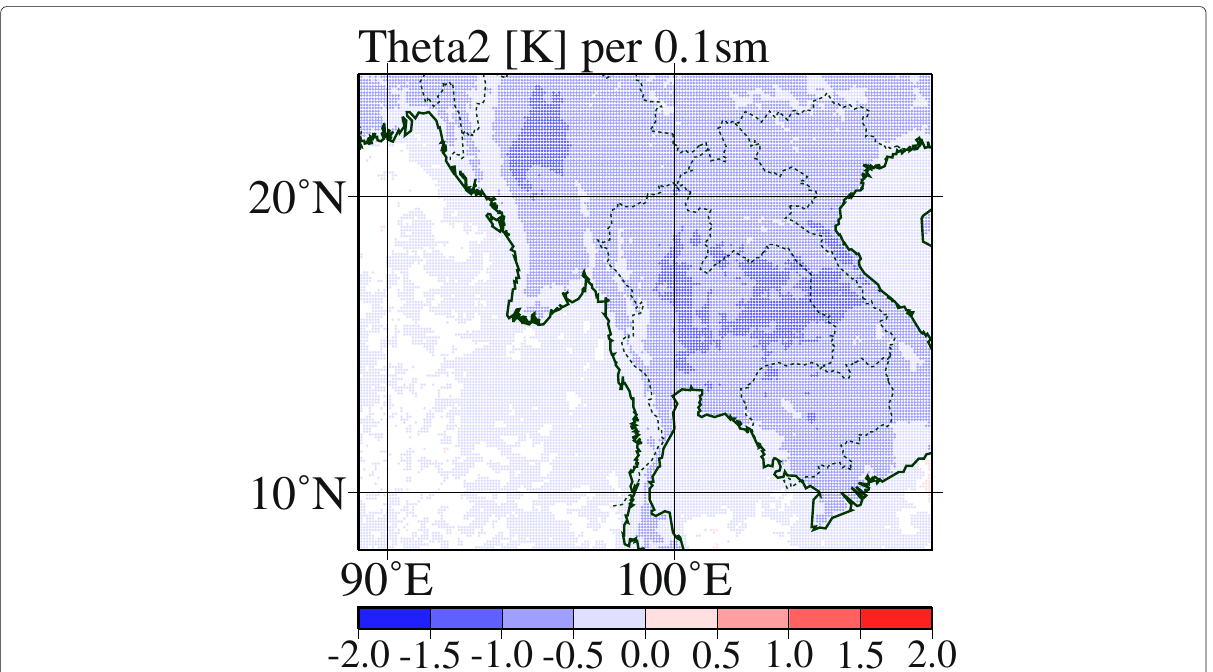
Fig. 11 Same as Fig. 3 but for potential temperature at 2 m above the surface. The unit is K per 0.1 increase in soil moisture